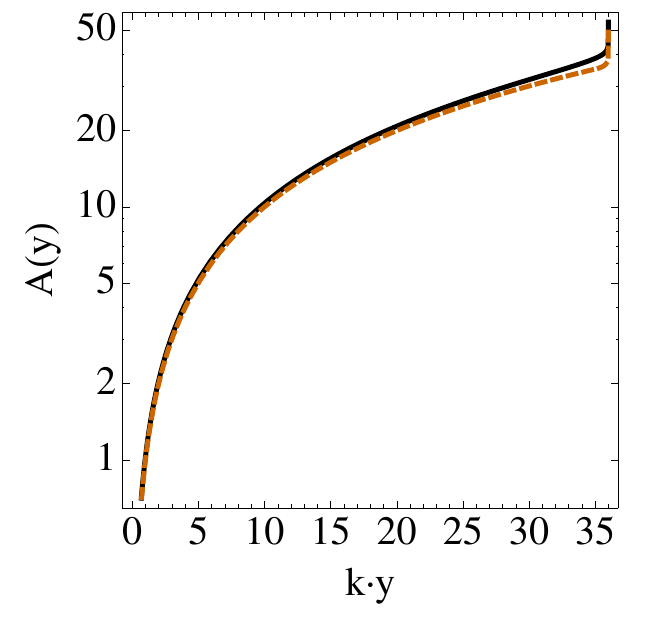
Figure 1 . The warp factor A ( y ) for the exact solution (solid line) of eq. (2.13) and the approximate solution (dashed line) of eq. (2.17). We have considered ky s = 36